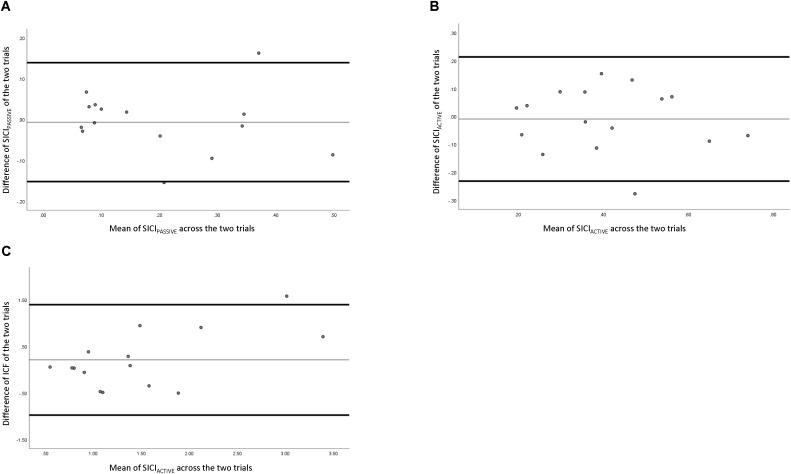
Bland–Altman plot of intracortical measures across two testing sessions. (A) Passive short-interval intracortical inhibition, (B) active short intracortical inhibition, and (C) intracortical facilitation.